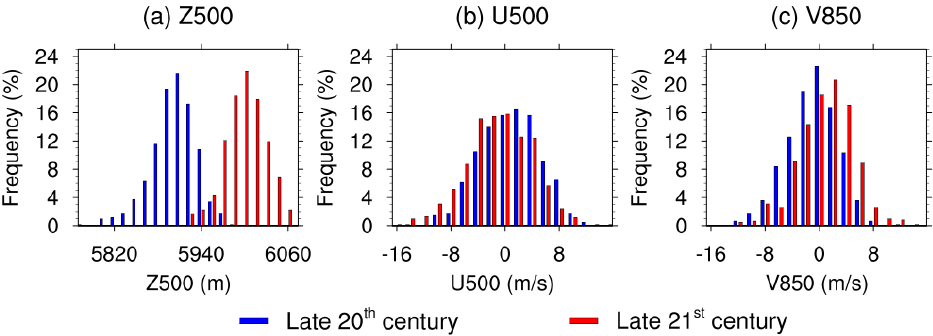
Figure 7. Changes to several climatic variables in southeastern China under the future scenario: ( a ) Z500 (m), ( b ) U500 (m / s), ( c ) V850 (m / s).